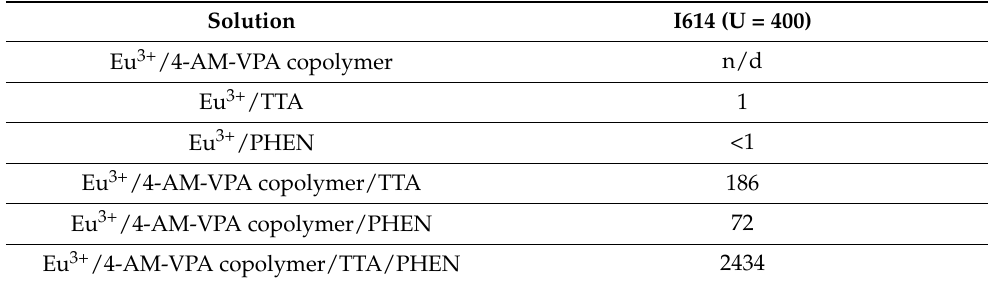
Table 3. The I 614 values for complexes of Eu 3+ with VPA copolymers in aqueous solutions in the presence of sensitizers.